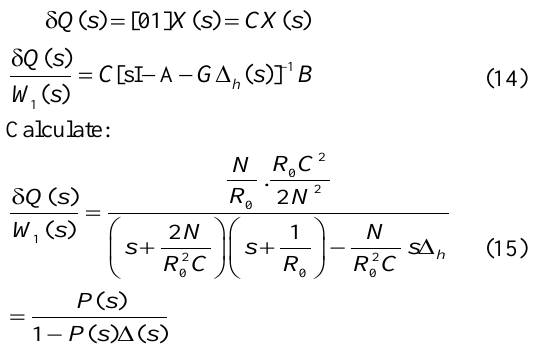
Figure 4. Linear analysis model for AQM